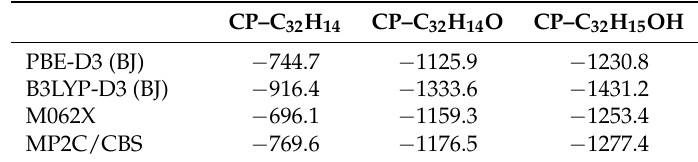
Table 1. Total energy for the interaction of cisplatin (CP) adsorbed on the smallest graphene oxide (GO) molecular prototypes (C 32 H 14 , C 32 H 14 O and C 32 H 15 OH). The reported values correspond to the most stable configurations reported in Figure 2 and obtained at the PBE-D3 (BJ) level. Estimations at the B3LYP-D3 (BJ) and M062X DFT levels are also given as well as the reference MP2C value obtained considering a complete basis set (CBS) extrapolation. All values are in meV (1 kcal/mol = 43.37 meV) and are corrected to account for the basis set superposition error (BSSE).